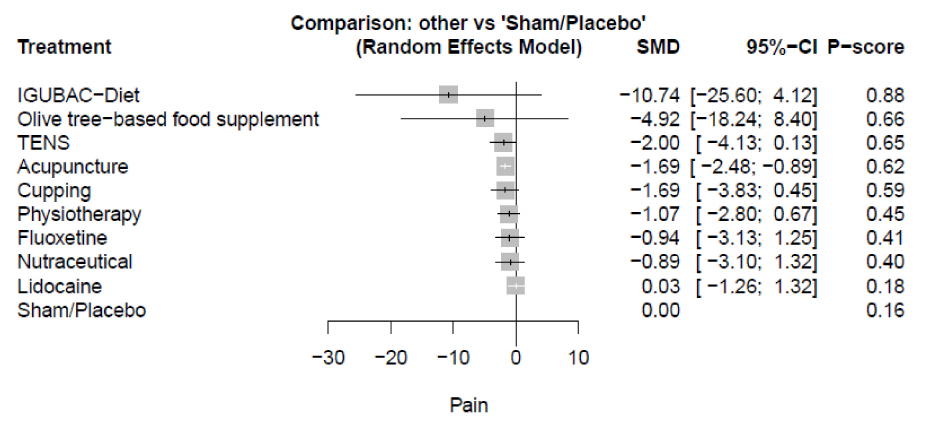
Figure 4. Plot of pain; SMD: standardized mean difference, CI: confidence